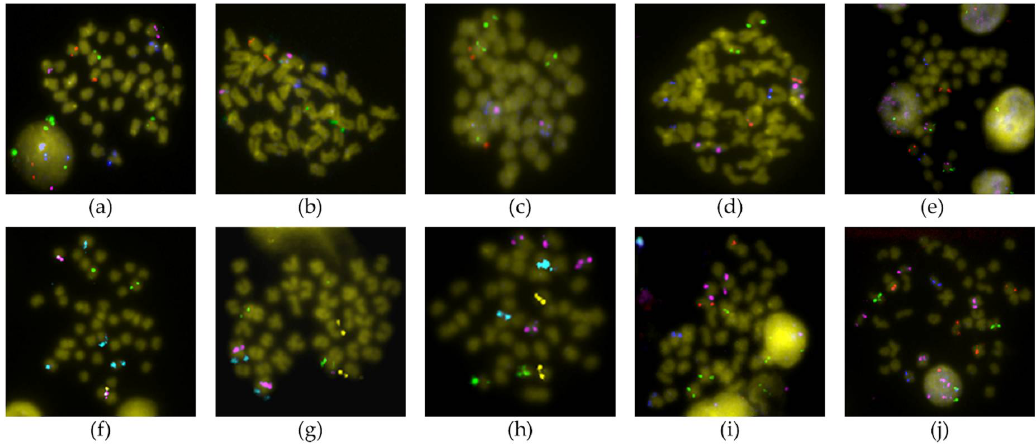
Figure 2. Representative BAC-FISH showing a marker in each chromosome of Solea senegalensis . ( a ) 4M14 (green)—15I19 (red)—22C2 (pink)—32B8 (blue); ( b ) 63A3 (green)—63A7 (red)—8O7 (pink)—9J4 (blue); ( c ) 19J21 (green)—6P22 (red)—7H22 (pink)—19H9 (blue); ( d ) 63A7 (green)—30H22 (red)—4N21 (pink)—13F4 (blue); ( e ) 4F12 (green)—36M2 (red)—36E3 (pink)— 31A2 (blue); ( f ) 4N21 (green)—71N11 (yellow)—53D20 (pink)—30J4 (cyan); ( g ) 10L10 (green)—71N11 (yellow)—38N10 (pink)—52G10 (cyan); ( h ) 13E1 (green)—38F24 (yellow)—9E8 (pink)—4M14 (cyan); ( i ) 46P22 (green)—71N11 (red)—20D18 (pink)—19H9 (blue); ( j ) 29D4 (green)—21O23 (red)—30J4 (pink)—4F12 (blue).